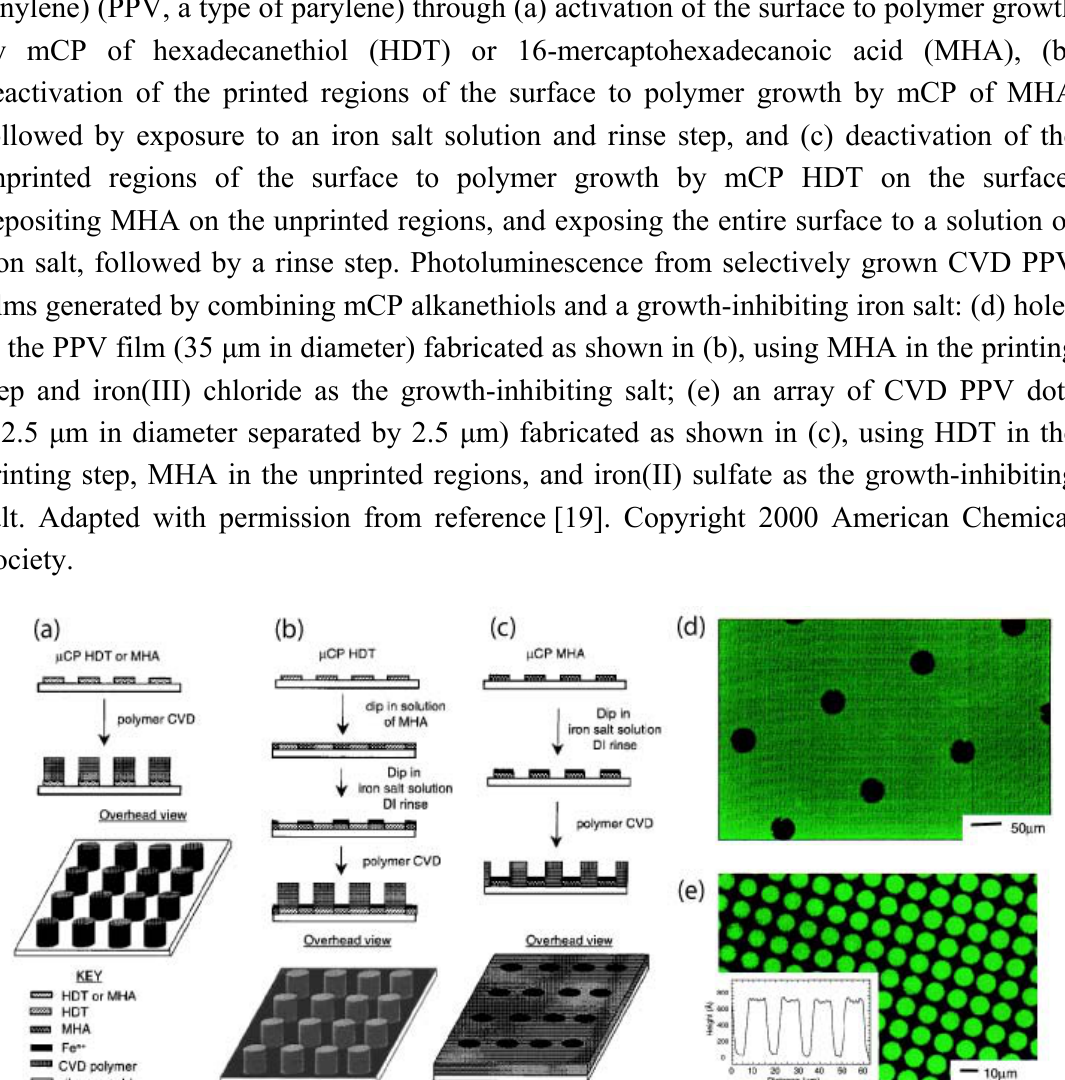
Figure 17. Use of mCP to control the growth of CVD parylenes and poly(p-phenylene vinylene) (PPV, a type of parylene) through (a) activation of the surface to polymer growth by mCP of hexadecanethiol (HDT) or 16-mercaptohexadecanoic acid (MHA),